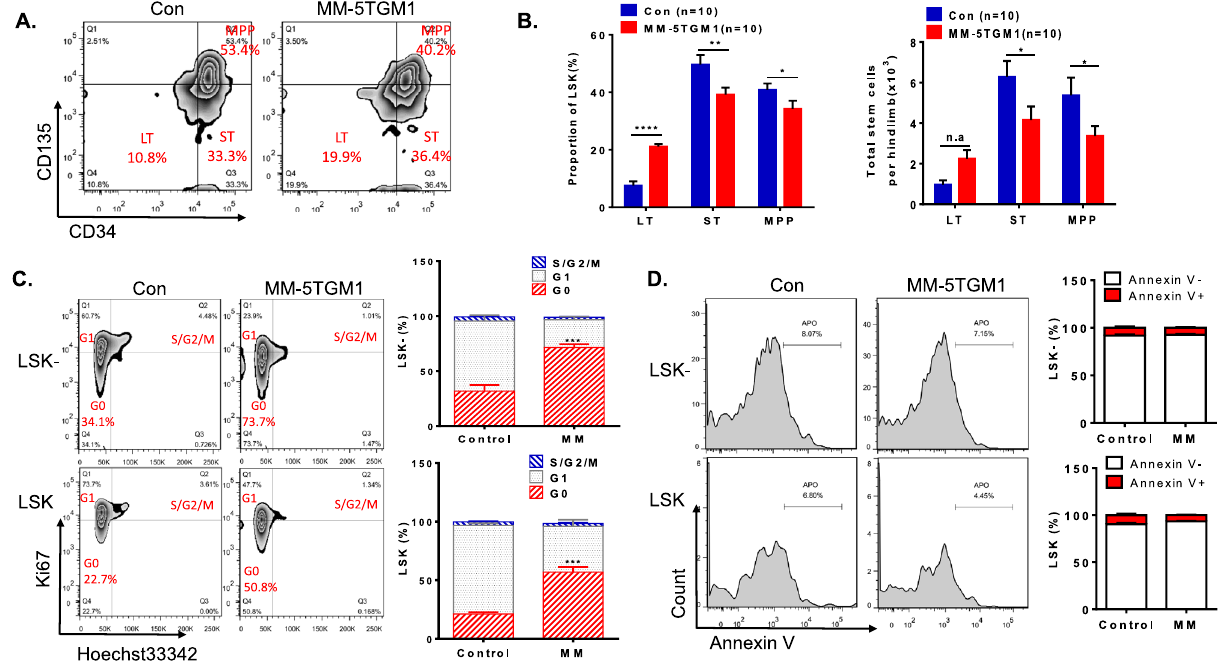
Figure 3. The differentiation of HSPCs arrested in the HSC stage in the myeloma bone marrow. ( A ) The subset of LSK cells, including LT-HSCs (Lin − , c-kit + , Sca-1 + , CD34 - , CD135 − ), ST-HSCs (Lin − , c-kit + , Sca-1 + , CD34 + , CD135 − ), and MPPs (Lin − , c-kit + , Sca-1 + , CD34 + , CD135 + ), was determined in BM samples. ( B ) The proportions and absolute numbers of the LSK subset are shown. ( C ) Representative flow graphs (left) and histograms (right) show the cell cycle status of LSK − (Lin − c − Kit + Sca-1 - ) and LSK (Lin − c − Kit + Sca-1 + ) cells in BM from MM-5TGM1 mice and tumour-free control mice (n = 6 in each group). ( D ) Apoptosis of LSK - and LSK cells from MM-5TGM1 mice and tumour-free control mice is shown (n = 6 per